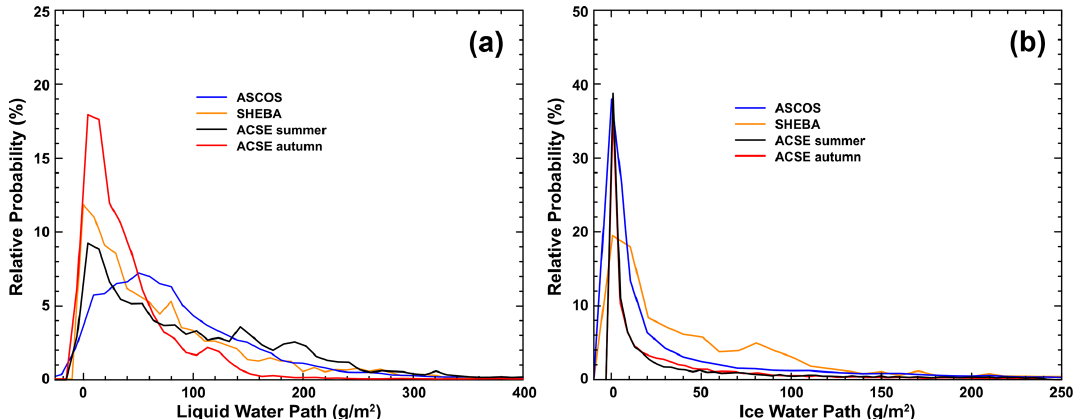
Figure 15. Relative probability of (a) LWP and (b) IWP for mixed-phase clouds observed during ACSE in summer (black) and autumn (red) in comparison to previous observations during ASCOS (blue) and SHEBA (orange). Figure adapted from Fig. 17 in Tjernström et al.